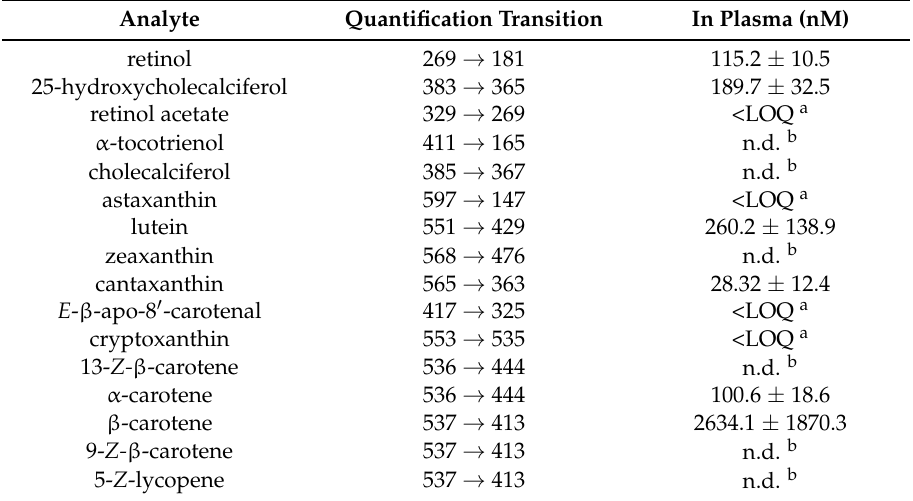
Table 6. Carotenoids and fat-soluble vitamins quantified in plasma by the HPLC-MS/MS method. Analyte Quantification Transition In Plasma (nM) retinol 269 → 181 115.2 ± 10.5 25-hydroxycholecalciferol 383 → 365 189.7 ± 32.5 retinol acetate 329 → 269 <LOQ a α -tocotrienol 411 → 165 n.d. b cholecalciferol 385 → 367 n.d. b astaxanthin 597 → 147 <LOQ a lutein 551 → 429 260.2 ± 138.9 zeaxanthin 568 → 476 n.d. b cantaxanthin 565 → 363 28.32 ± 12.4 E - β -apo-8 (cid:48) -carotenal cryptoxanthin α -carotene 536 → 444 100.6 ± 18.6 β -carotene 537 → 413 2634.1 ± 1870.3 537 → 413 n.d. b 5- Z -lycopene 537 → 413 n.d.